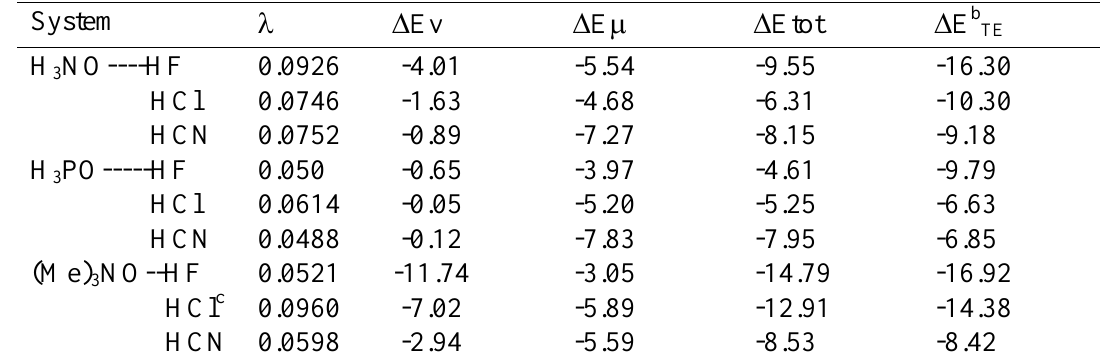
Table 2 : The interaction energies for the hydrogen bonded complexes (Energies in kcal/mol) a